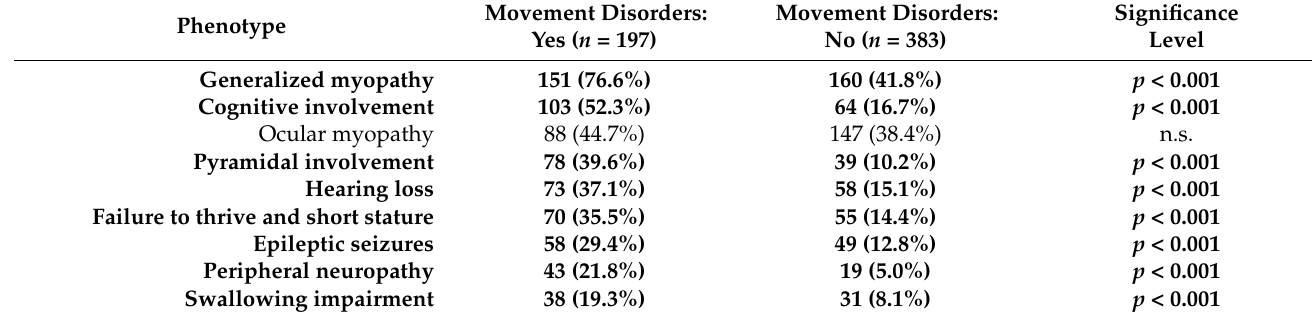
Table 1. Phenotype-based findings in childhood-onset mitochondrial patients with and without movement disorders. Patients included in the database of the Nationwide Italian Collaborative Network of Mitochondrial Diseases were divided into two groups: with and without movement disorders. Clinical features present in fewer than 10% in the first group were not considered and are not shown. Ocular myopathy includes eyelid ptosis and ophthalmoparesis. Generalized myopathy includes at least one of the following: muscular weakness, exercise intolerance, muscle wasting, hypotonia, muscle pain, or myoglobinuria. Significance level after Bonferroni’s correction: 0.0033. Significant differences are shown in bold. n.s.: not